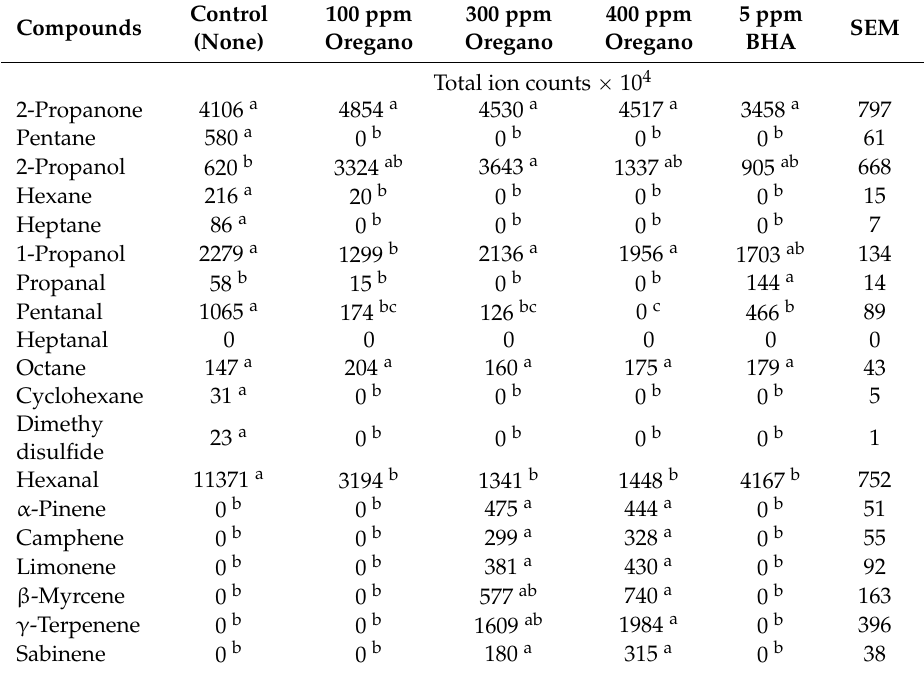
Table 5. Profile of volatiles from cooked chicken breast meat with different levels of oregano oil at day 3.